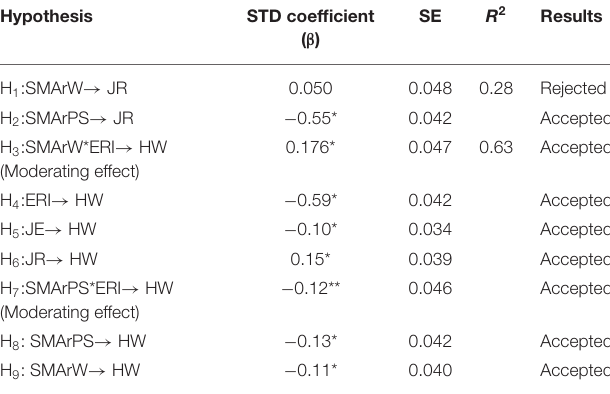
TABLE 7 | Structural model